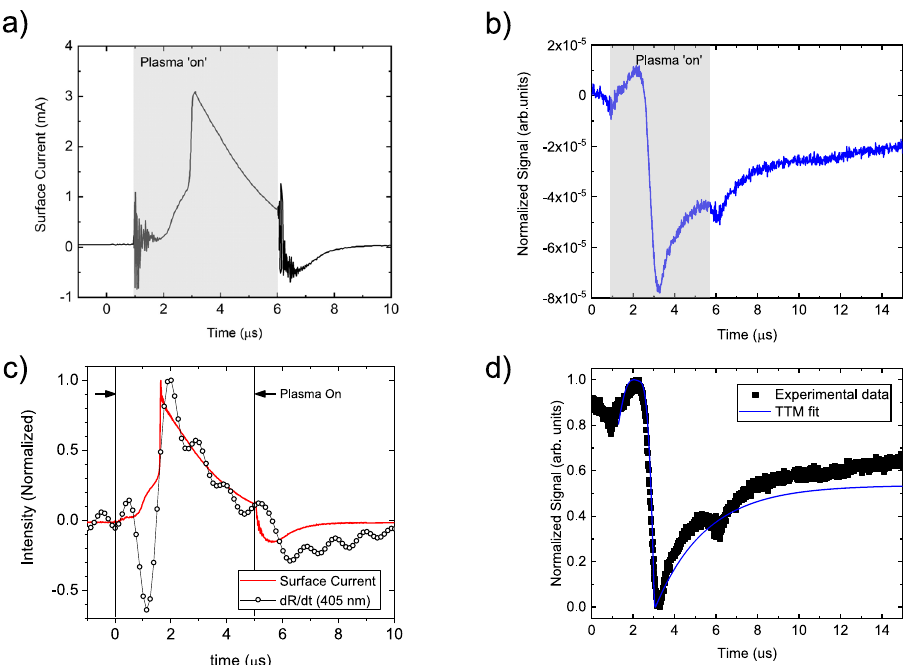
Fig. 2 Transport measurements of an atmospheric plasma jet. a The measured surface current of the Au fi lm and b the measured thermore fl ectance of the Au surface as a function of time for a 5 μ s plasma pulse. The laser probe wavelength is 654 nm. c Measured surface current (solid red line) overlaid with the temporal derivative of the measured changed in re fl ectivity due to the plasma pulse (open circles). The laser probe wavelength here is 405 nm. The two are in reasonable agreement, aside from the reduction in surface temperature ~1 μ s, indicating Joule heating to be the primary mechanism of energy transfer from the plasma to the Au surface. d Measured thermore fl ectance data from b due to the plasma pulse (black dots) and two-temperature model calculations for the sample system (solid blue line). The observed cooling is attributed to the removal of adsorbed species on the Au